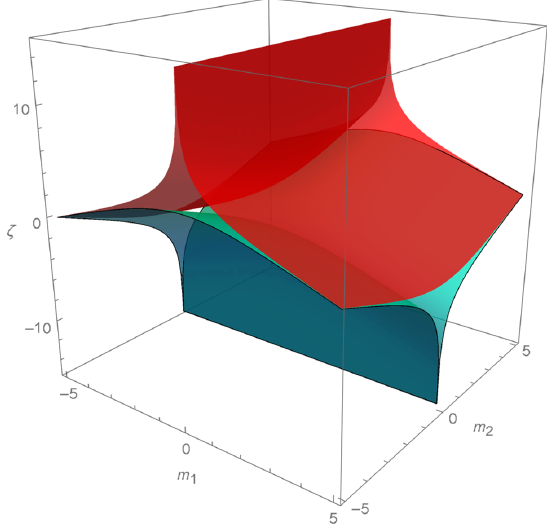
Figure 2 . Discriminant locus of SQED 2 model compactified on a circle. The red sheet corresponds to the top sign in (2.9) and cyan sheet to the bottom